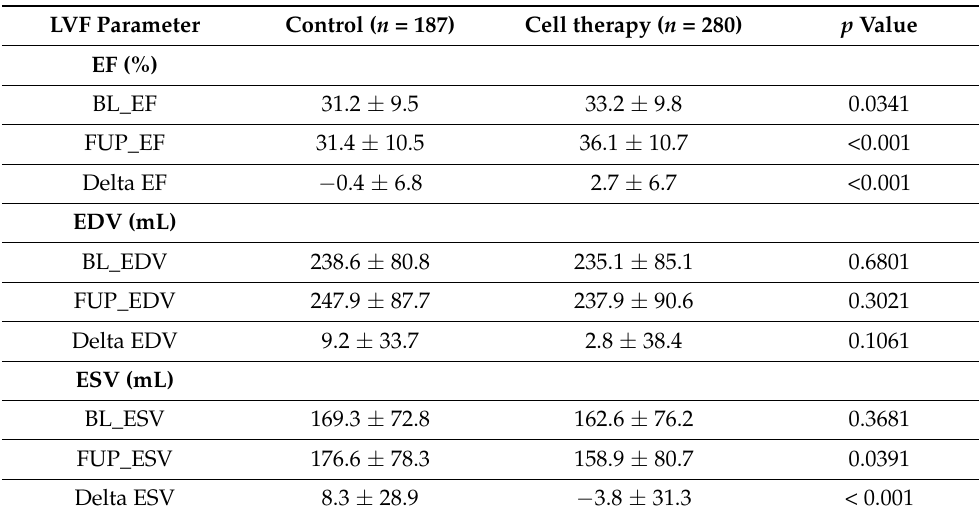
Table 4. Secondary endpoints: left ventricular baseline (BL) and follow-up (FUP) parameters, based on the ACCRUE-IPD data.